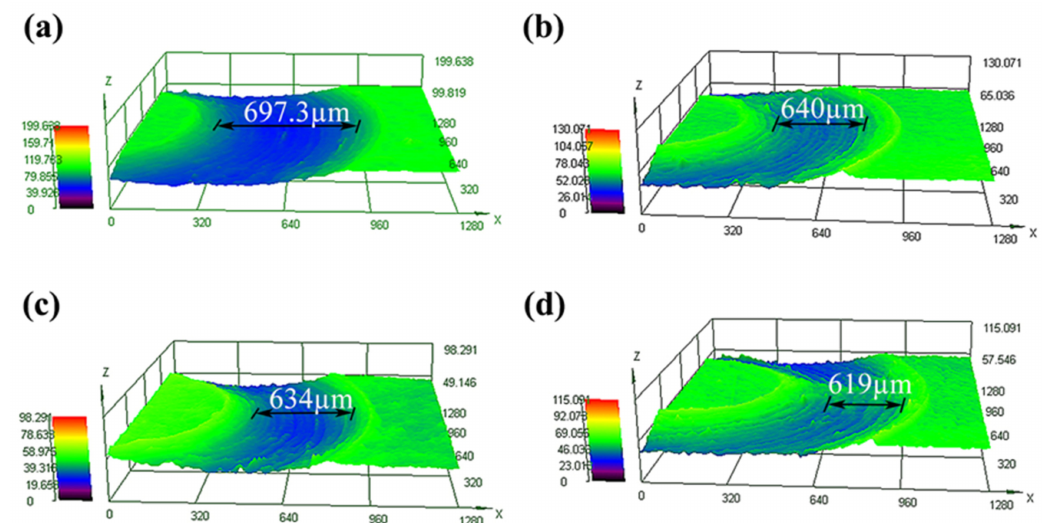
Figure 8. LSM pictures of initial and Nb-alloyed samples. ( a ) Initial; ( b ) 20 pulses; ( c ) 30 pulses; ( d ) 40 pulses.